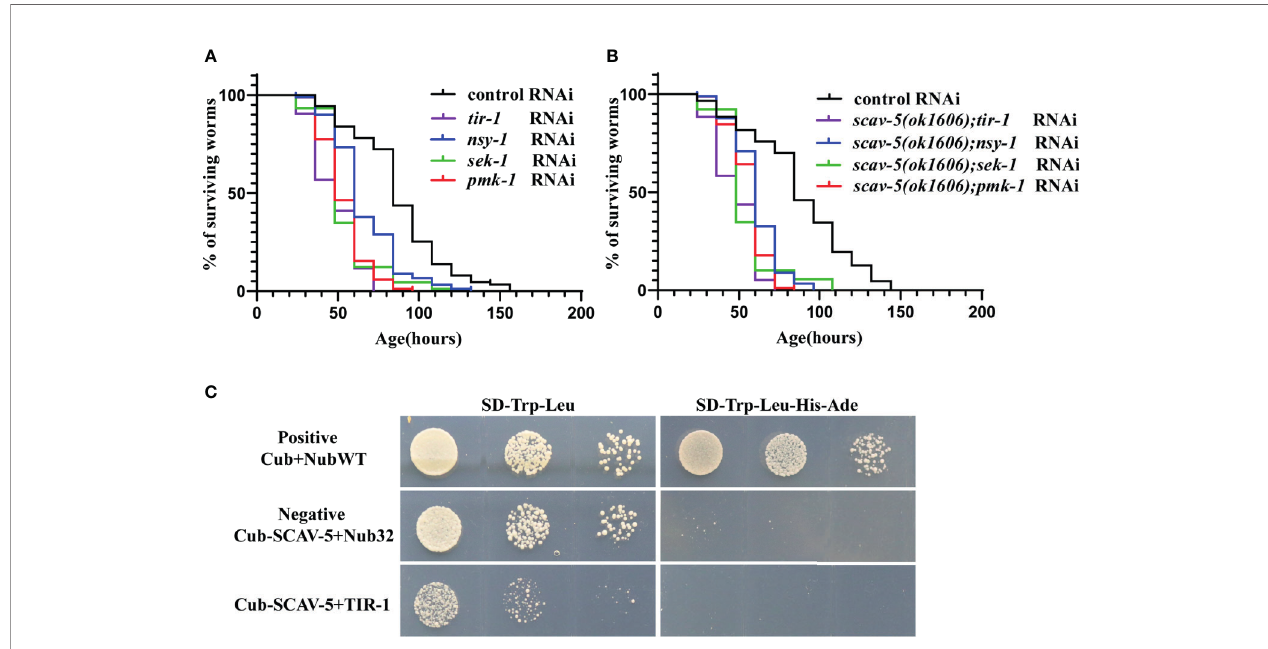
FIGURE 7 | Genetic epistatic analysis of scav-5 in the PMK-1 pathway defense against P. aeruginosa PA14 and test of the interaction SCAC-5 with TIR-1. (A, B) Survival curves of wild type (A) and scav-5(ok1606) mutants (B) with tir-1, nsy-1, sek-1, pmk-1 RNAi cultured on P. aeruginosa PA14. (C) Analysis of interaction between SCAV-5 and TIR-1 by yeast two hybrid. The yeast solution was diluted by three gradients in each group, which were cultured on SD-Trp-Leu medium (left) and SD -Trp-Leu-His-Ade medium